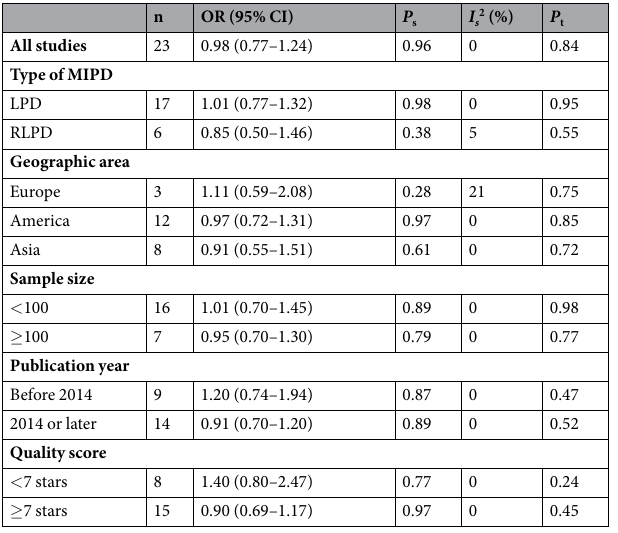
Table 3. Subgroup analyses of MIPD vs OPD. P s : P value for heterogeneity within each subgroup; Pt : test for overall effect; I s2 : I 2 value for heterogeneity within each